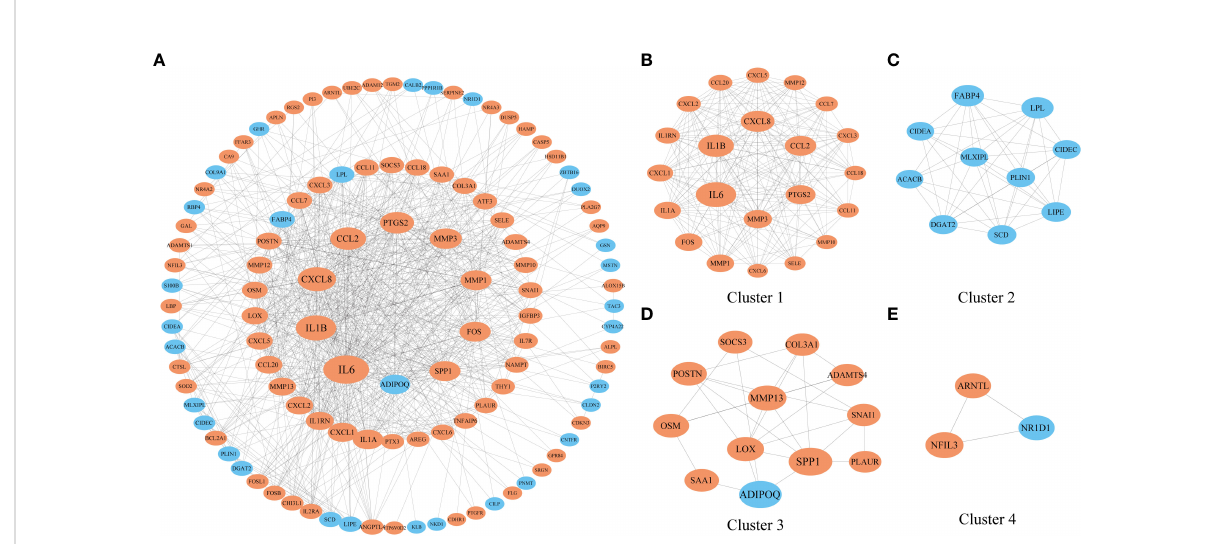
FIGURE 5 Construction of a PPI network of genes that coexpressed with NFIL3. (A) The PPI network with 112 nodes and 719 edges was constructed based on the STRING dataset and visualized by Cytoscape. (B – E) Four signi fi cant clusters were identi fi ed from the network by MCODE. The nodes with orange color represent the upregulated genes, while those with blue color represent the downregulated genes. The shape size of the nodes is arranged by the degree in the network. PPI, protein – protein interaction.